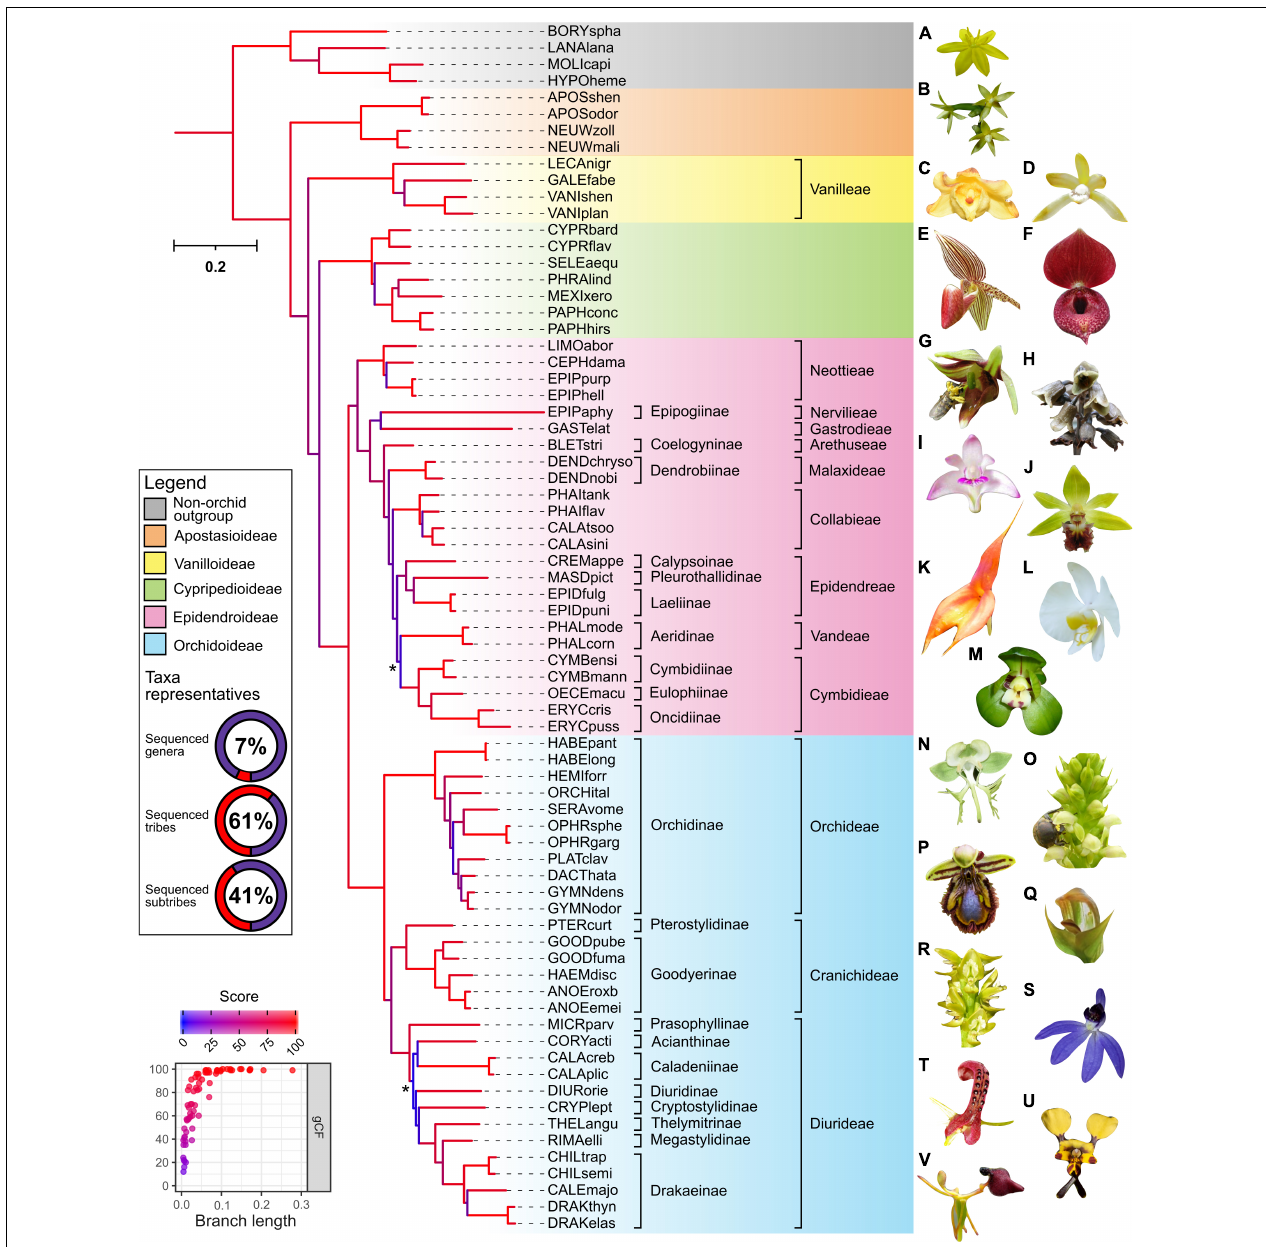
FIGURE 1 | Outcomes of phylogenetic analysis across the Orchidaceae from repurposed multi-tissue transcriptomes. The maximum-likelihood IQ-TREE phylogeny of 69 orchids (spanning 5 subfamilies, 13 tribes, 21 subtribes, and 48 genera) and four non-orchid species as outgroup was based on partition analysis of 633 amino-acid alignments with a total of 317,221 (139,913 parsimony-informative) sites (see Supplementary Methods for details). The abbreviated species name is shown (see Supplementary Table 1 for details). Background color indicates subfamily grouping. The donut chart depict the taxonomic representativeness of included orchid genera, subtribe, and tribe (see relevant placeholder in the phylogeny for details). Asterisk indicate ultrafast bootstrap (UFboot) or SH-aLRT branch support < 95 and < 80%, respectively. Branch length indicates the total number of substitutions per site and branch colors correspond to gene concordance factors (gCF)–the proportion of gene trees that decisively support the given bifurcation. Inset (bottom left) shows a strong positive relationship of gCF scores with branch length. See Supplementary Figure 2 for additional details on the corresponding shortcut coalescent ASTRAL phylogeny. Representative species of the outgroup (A) Hypoxis hirsuta and subfamilies across the Orchidaceae are indicated (B) Apostasia nipponica –Apostasioideae; (C) Galeola lindleyana and (D) Lecanorchis suginoana –Vanilloideae; (E) Paphiopedilum rothschildianum and (F) Cypripedium lichiangense –Cypripedioideae; (G) Epipactis veratrifolia , (H) Gastrodia fontinalis , (I) Dendrobium kingianum , (J) Calanthe tricarinata , (K) Masdevallia veitchiana , (L) Phalaenopsis amabilis , and (M) Cymbidium goeringii –Epidendroideae; (N) Habenaria limprichtii , (O) Satyrium microrrhynchum , (P) Ophrys speculum , (Q) Pterostylis curta , (R) Prasophyllum elatum , (S) Cyanicula caerulea , (T) Cryptostylis leptochila , (U) Diuris pardina , and (V) Drakaea glyptodon –Orchidoideae. All images have been reproduced with permission from the respective copyright holders. Please refer to the section “Acknowledgments” for image credits.